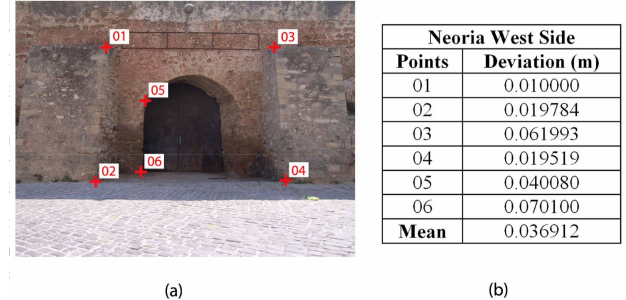
Figure 12. Accuracy assessment via GCP of Neoria west side façade: ( a ) GCP distribution along the façade; and ( b ) deviations of the GCP along with their mean